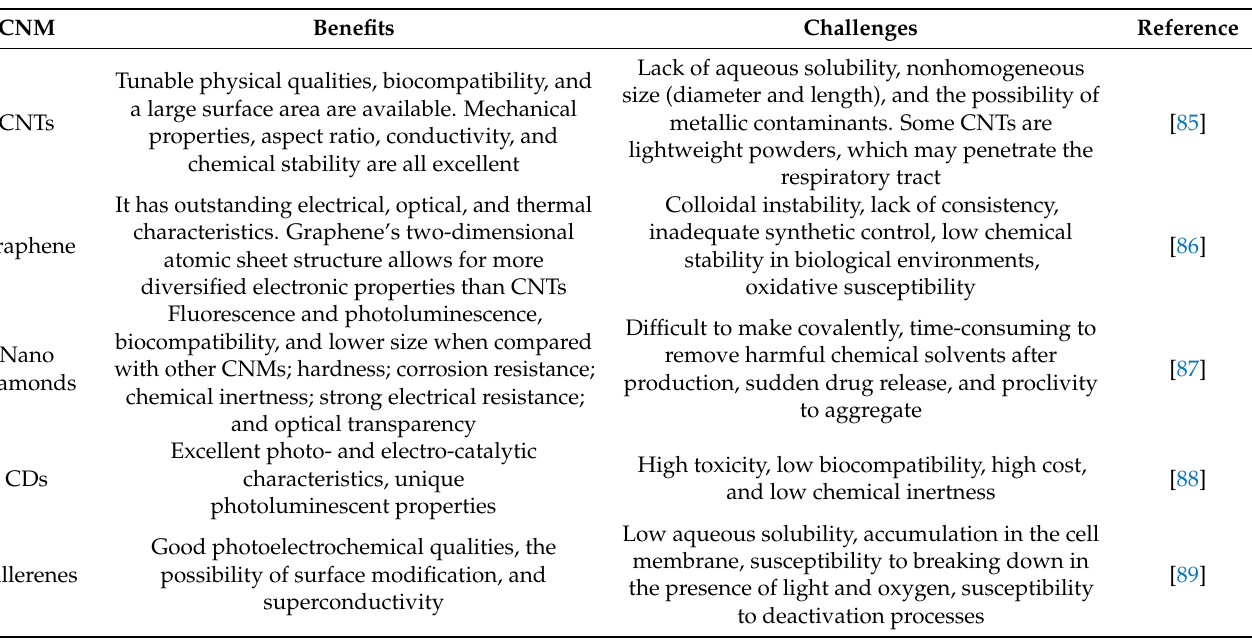
Table 4. Benefits and challenges of